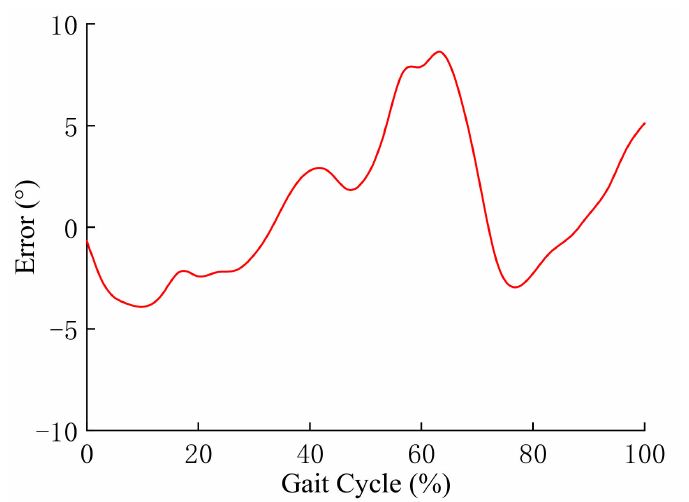
Figure 21. The swing trajectory error of the knee joint based on